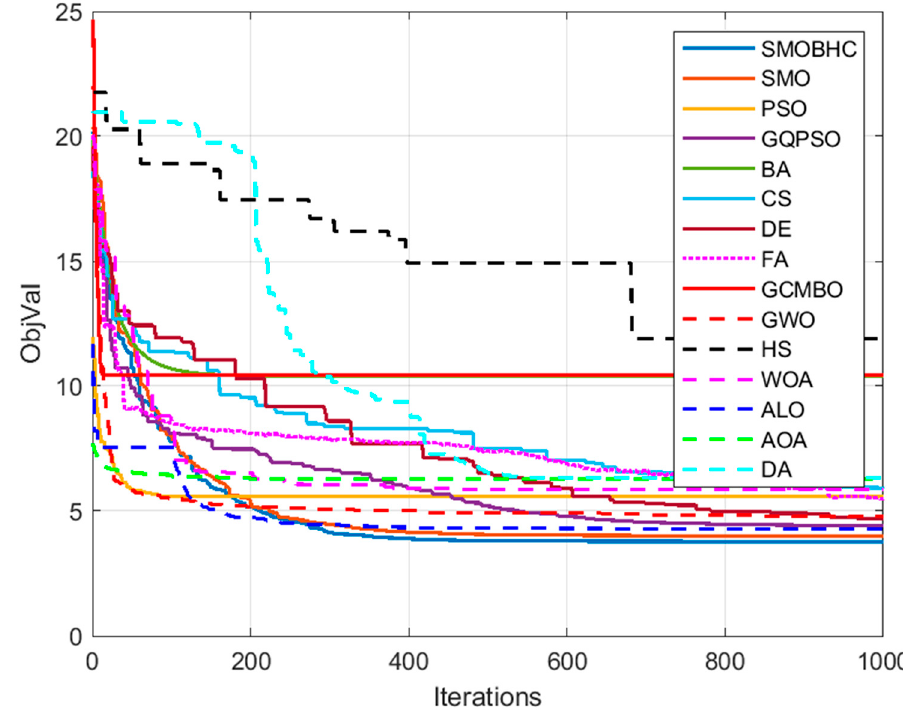
Figure 9. Comparative convergence curves of algorithms for battlefield 1 with D = 60.